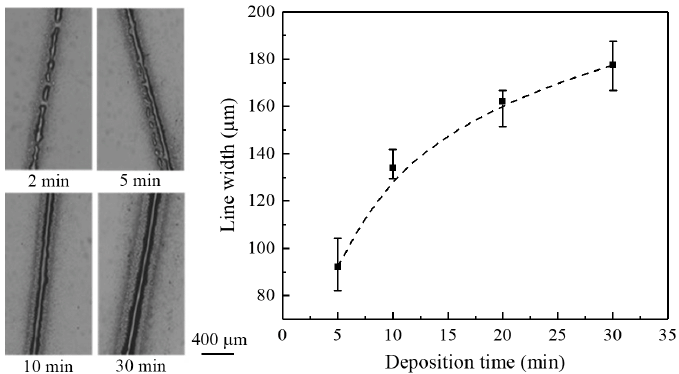
Figure 10. The effect of deposition time on line width. The nozzle-to-substrate distance is 0.5 mm, the applied voltage is 1.5 kV, and the flow rate is 100 μ L/h.